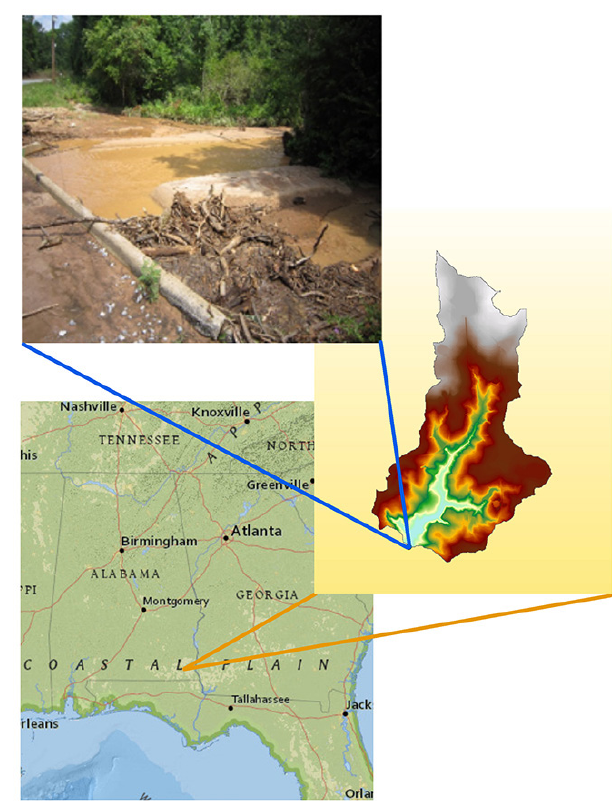
Figure 1. Location of Dean Road Bridge and Aggradation Problem.